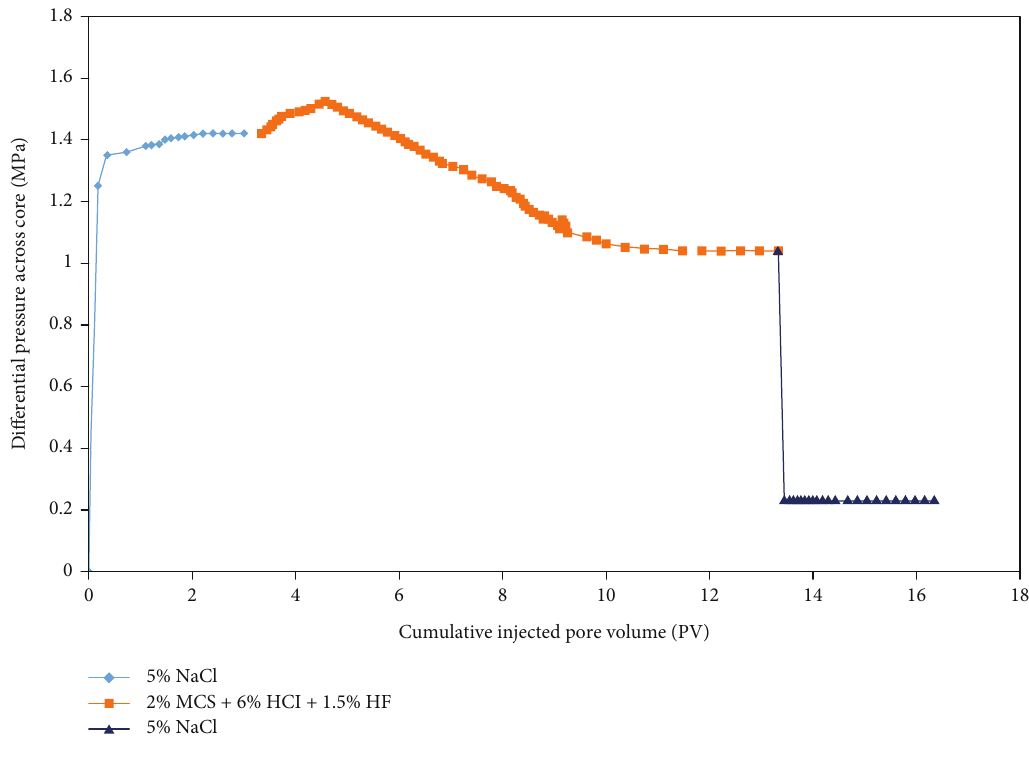
Figure 4: Pressure drop across A1 core injected with composite mud acid.